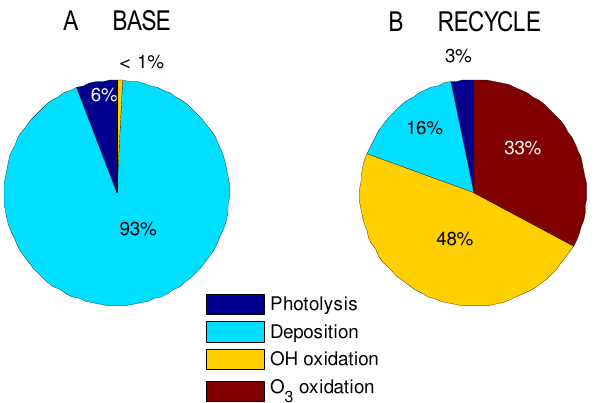
Fig. 8. The partitioning of the 24h, boundary-layer-averaged loss Figure 8 The partitioning of the 24 h, boundary layer averaged loss processes of MTNs in a) the 2 processes of MTNs in (a) the BASE case and (b) the RECYCLE BASE case and b) the RECYCLE case. The averaged total loss is 8% larger in the RECYCLE 3 case. The averaged total loss is 8% larger in the RECYCLE case case compared to the BASE case. Loss of MTNs through oxidation by OH or O 3 and by 4 compared to the BASE case. Loss of MTNs through oxidation by photolysis results in the return of NO x to the atmosphere. Loss of MTNs through deposition 5 OH or O 3 and by photolysis results in the return of NO x to the removes NO x from the atmosphere and introduces it into the biosphere. 6 atmosphere. Loss of MTNs through deposition removes NO x from the atmosphere and introduces it into the biosphere.